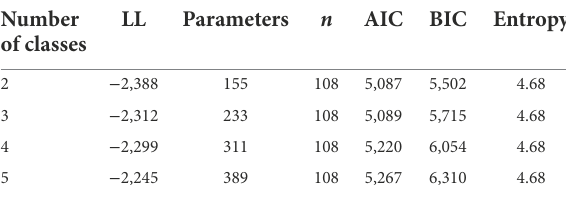
TABLE 2 The fit indices of latent class analyses with two to five classes.